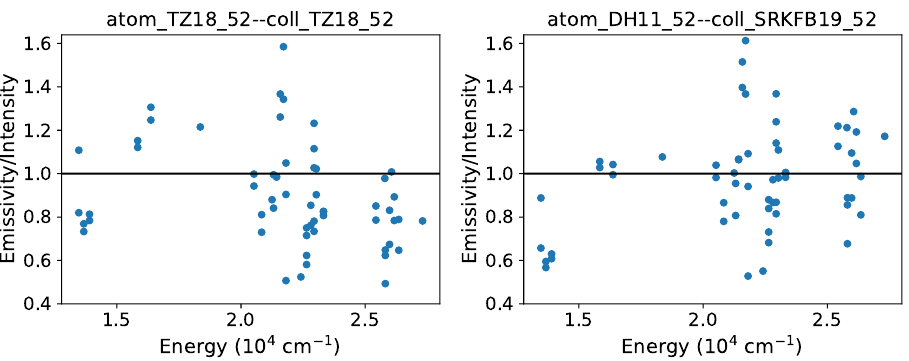
Figure 7. Ratio of the normalized theoretical emissivity and observed intensity for lines in HH202S as a function of the upper-level energy of the transition. Left panel : spectral fit with datasets atom_TZ18_52 and coll_TZ18_52 at T e = 7.94 × 10 3 K and n e = 3.29 × 10 4 cm − 3 . Right panel : spectral fit with datasets atom_DH11_52 and coll_SRKFB19_52 at T e = 11.1 × 10 3 K and n e = 2.58 × 10 4 cm − 3